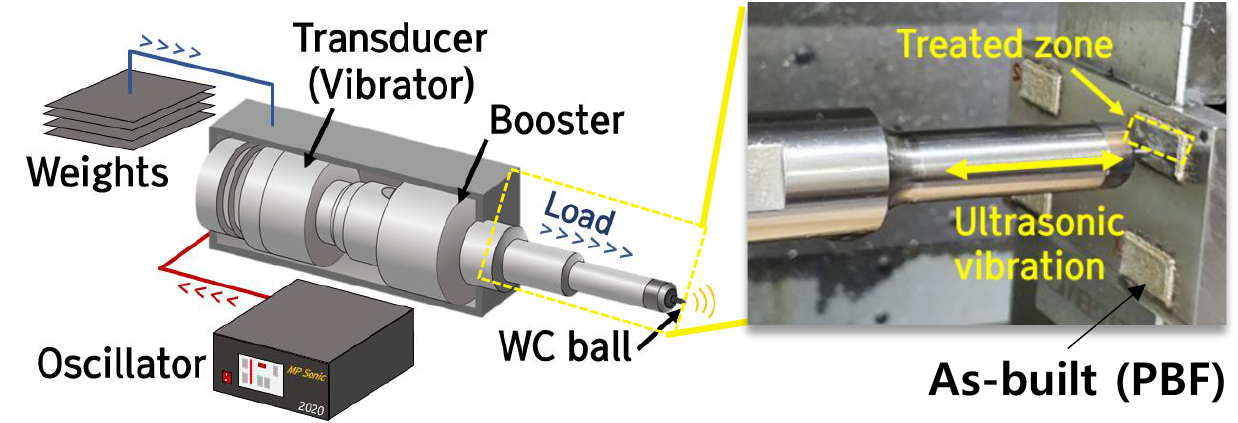
Figure 2. Experimental procedure for UNSM treatment on as-built specimen.